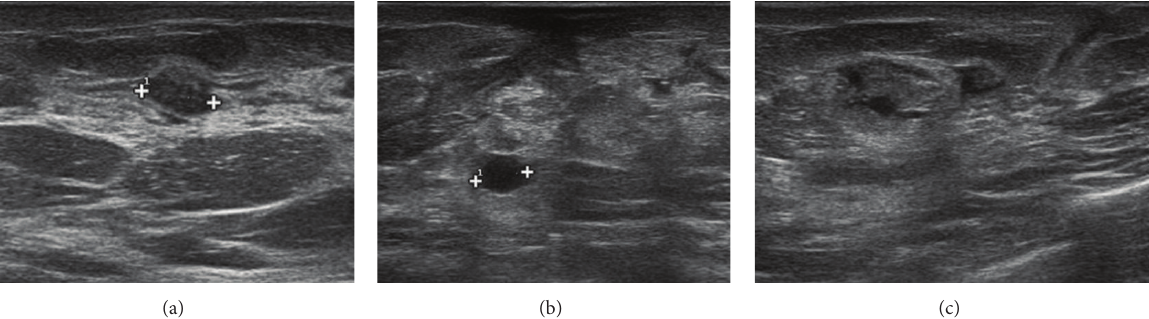
Figure 2: US shows hypoanechoic fluid confluent areas and in the upper outer quadrant (a) and in the lower outer quadrant (b and c) of the left breast and a diffused ipsilateral parenchymal and cutaneous